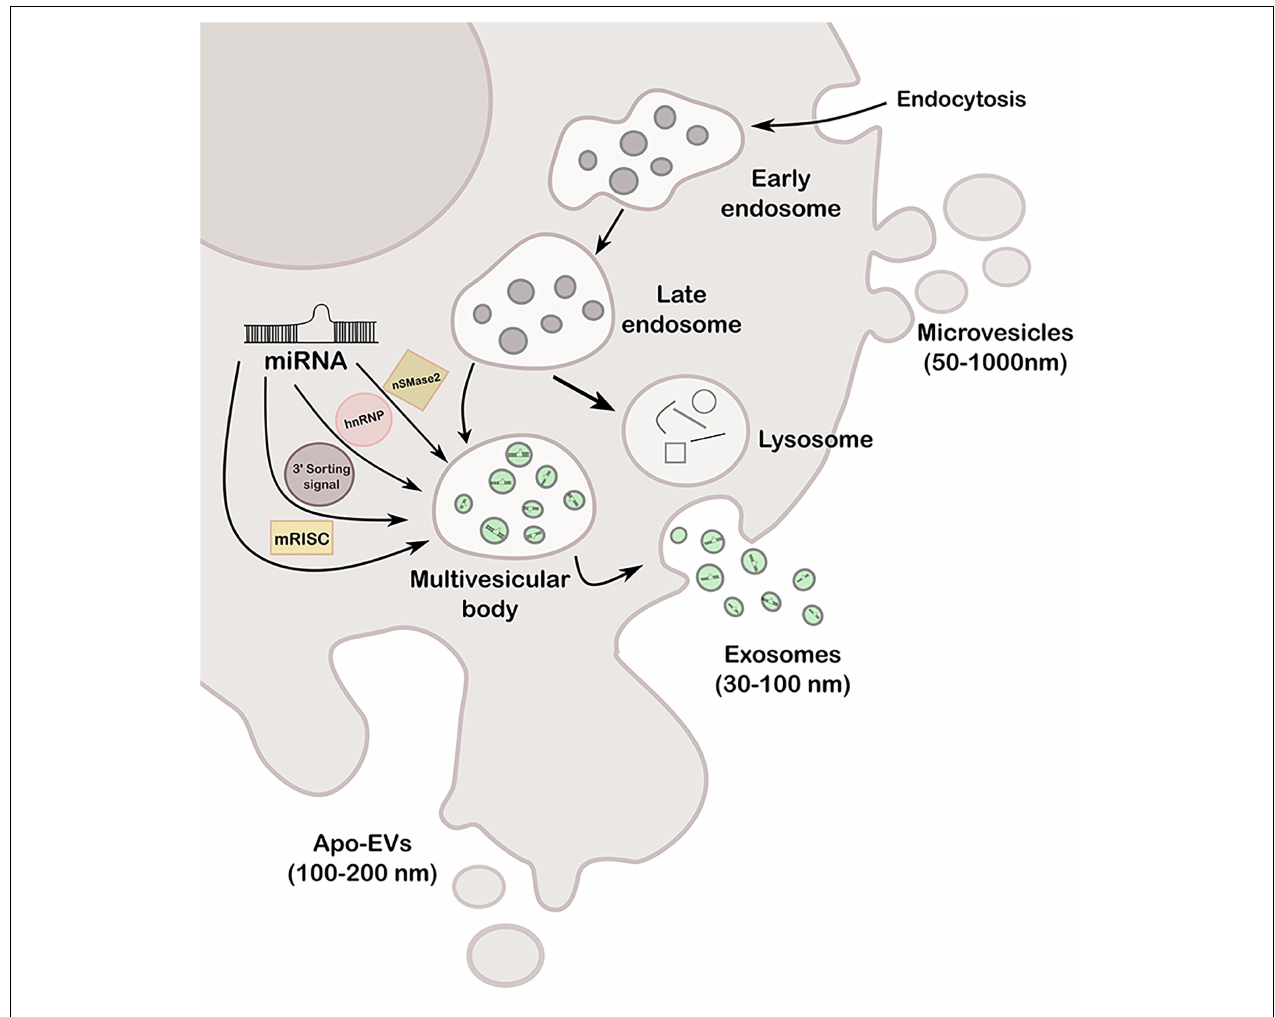
FIGURE 1 | Schematic representation of the different types of EVs (exosomes, microvesicles and apo-EVs), its formation mechanisms and miRNA loading pathways (nSMase2, hnRNP, 3 (cid:48) sorting signal and